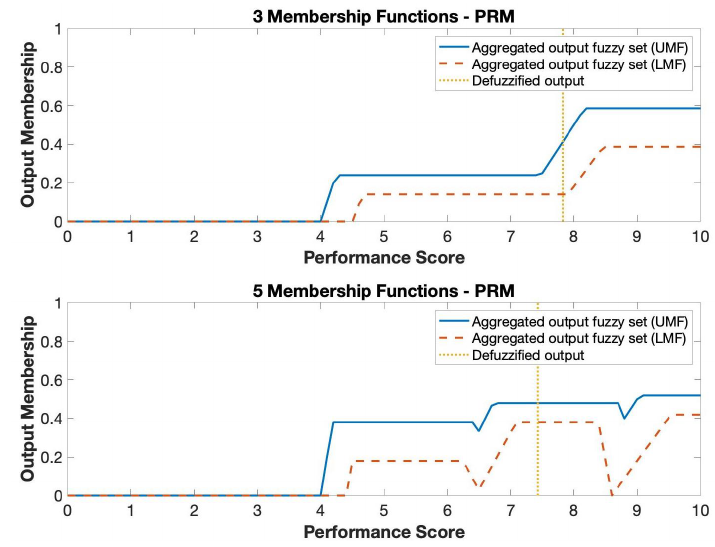
Figure 18. Output set for the PRM algorithm.